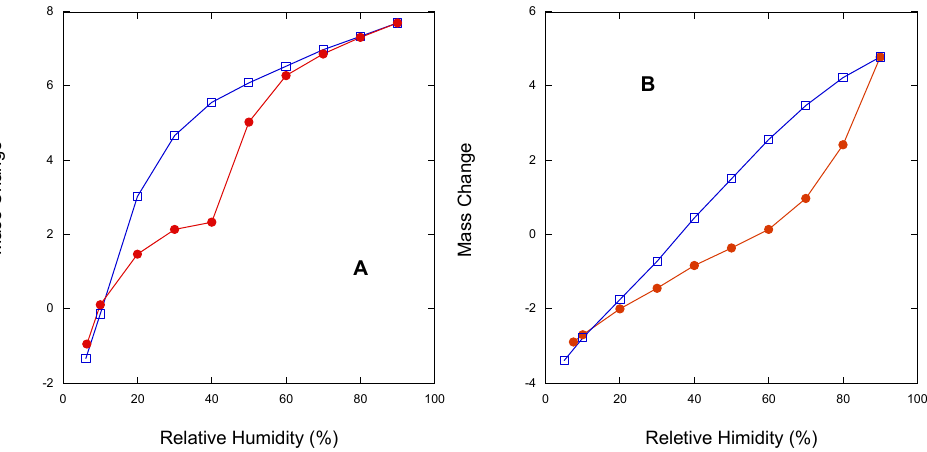
Figure 8. Isothermal Dynamic Vapor Sorption profiles at 25 °C of rifaximin α form ( A ), and amor- phous rifaximin ( B ). Ascending curve solid circle, descending curve empty square.